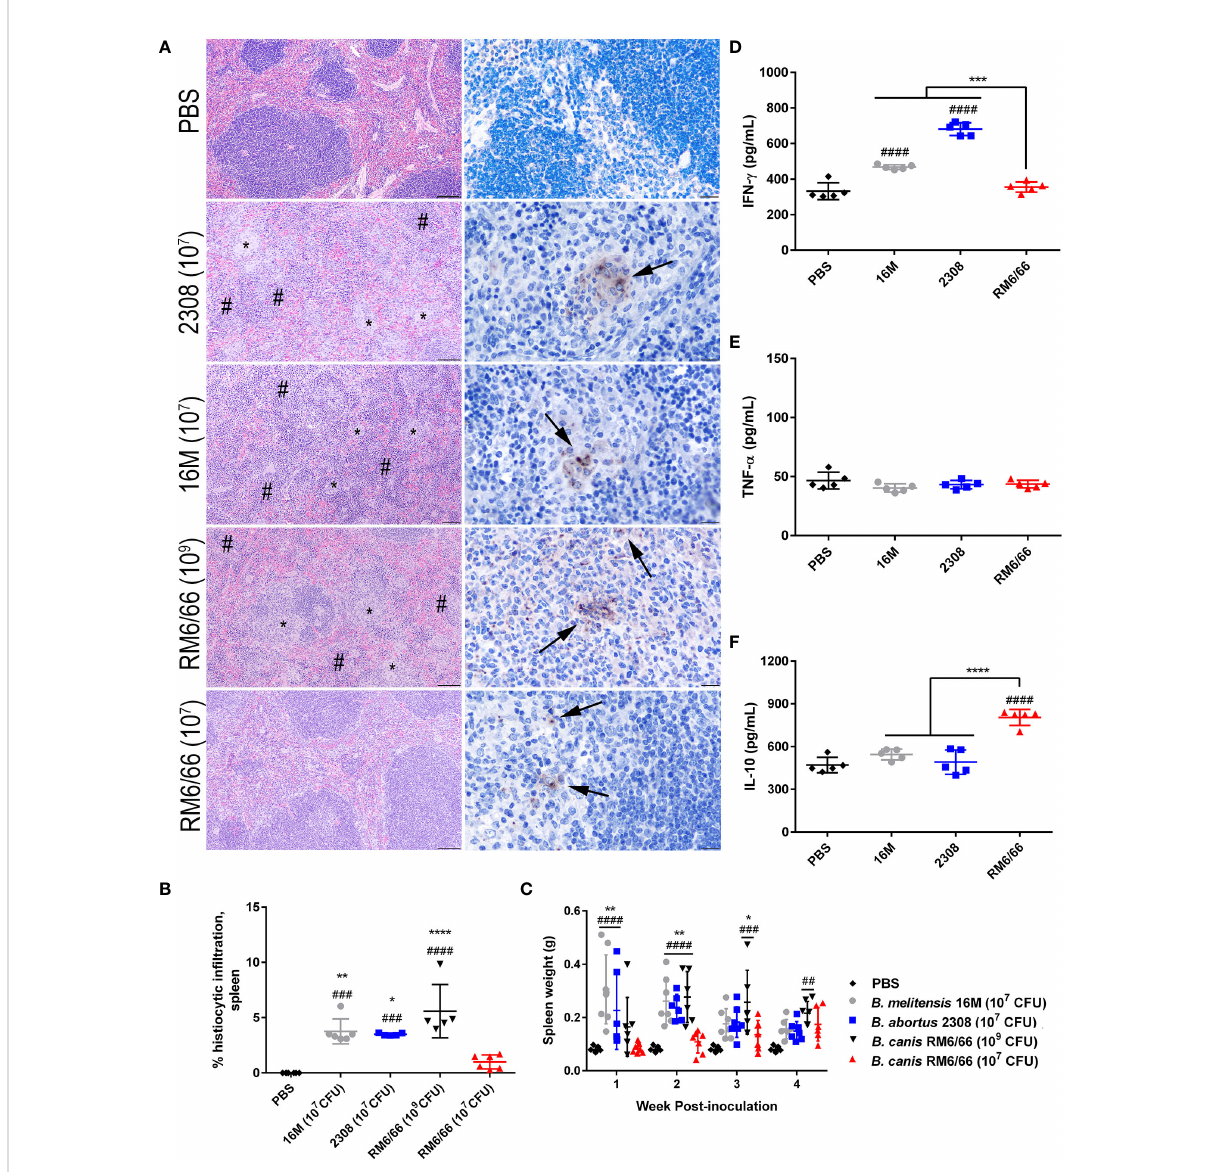
FIGURE 2 Intratracheal inoculation of mice with B . canis at 10 7 CFU results in less splenic histiocytic in fl ammation than B . abortus or B . melitensis at the same dose and does not result in splenomegaly. (A) Representative histologic images of the spleen from each group at 2-weeks post-infection showing foci of histiocytic in fi ltration (*) and extramedullary hematopoiesis (#) in the left column (H&E stain, 10x magni fi cation, scale bar= 100 µm) and positive intracytoplasmic immunolabeling for Brucella antigen (arrows) within these areas in the right column (IHC with DAB chromagen, 40x magni fi cation, scale bar= 20 µm). (B) Quanti fi cation of % histiocytic in fi ltration within the spleen at 2-weeks post-infection. Data were analyzed via one-way ANOVA and Tukey ’ s multiple comparisons test. (C) Splenic weight was measured at 1-4 weeks post- inoculation and compared at each time point using two-way ANOVA and Sidak ’ s multiple comparisons test. Measurement of cytokines in spleen homogenate supernatants at 2-weeks post-infection, including (D) IFN- g , (E) TNF- a , and (F) IL-10. Data were analyzed via one-way ANOVA and Tukey ’ s multiple comparisons test. Signi fi cant differences from B . canis 10 7 CFU are depicted (**p < 0.01, ***p < 0.001, ****p < 0.0001) and between infection groups and the PBS negative control group (##p < 0.01, ####p <